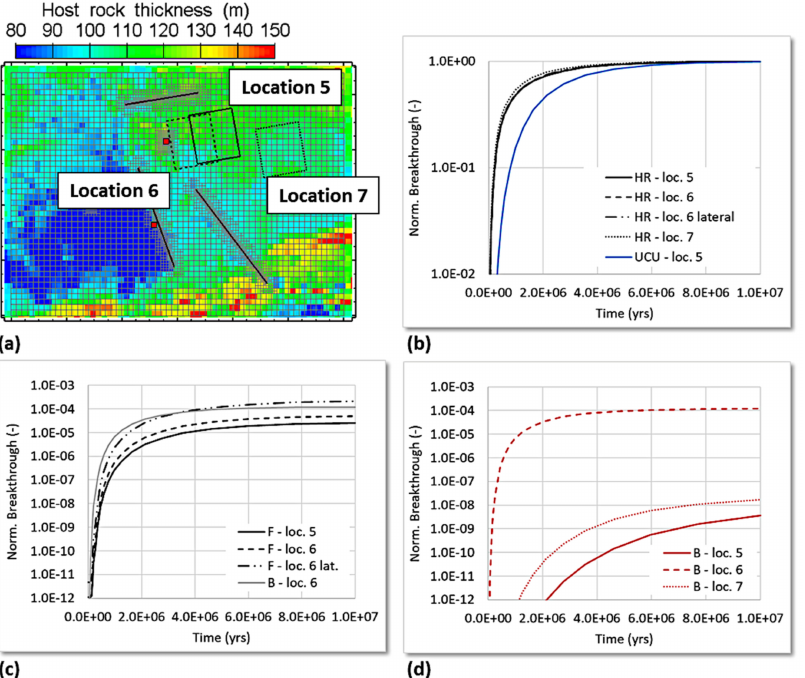
Figure 9. Exemplary 3D model used for variants of hydrogeologic conditions: ( a ) hypothetical repository locations in the vicinity of seismic faults and deep exploratory boreholes; ( b ) normalized tracer break- through to the upper confining units (UCU) through intact rock; ( c ) normalized tracer breakthrough to the UCU through faults; ( d ) normalized tracer breakthrough to the UCU through